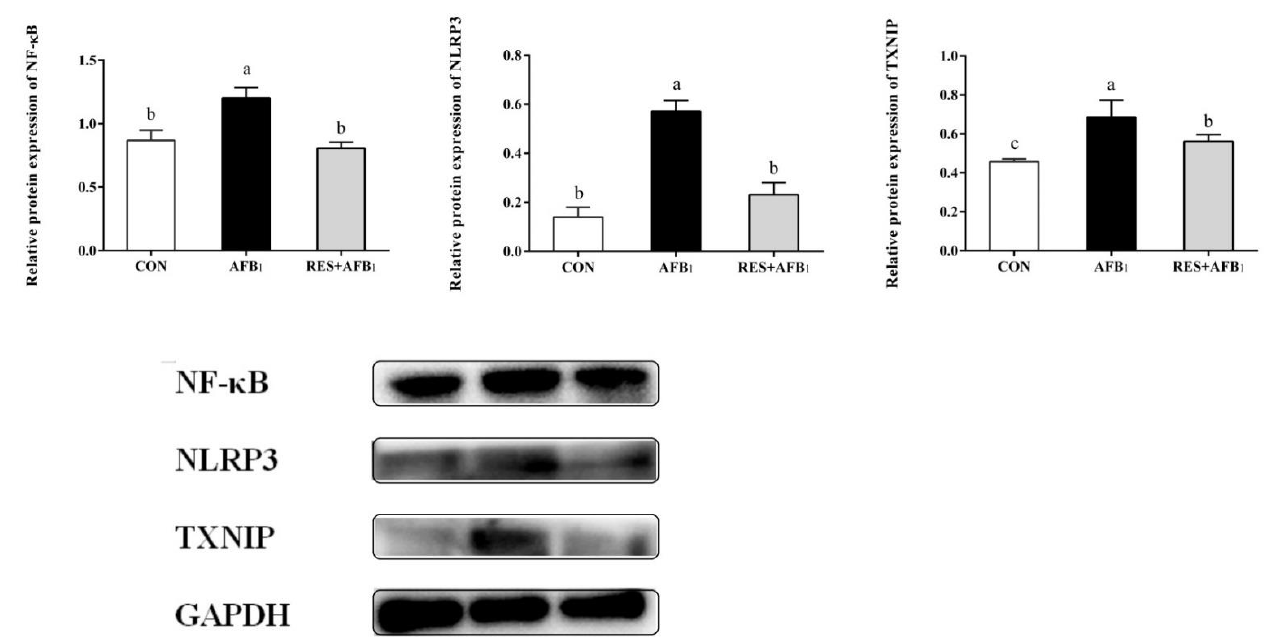
Figure 5. ( A – H ) Effect of RES on the mRNA expression levels of antioxidant genes in the ileum of AFB 1 -exposed duck. Values are expressed as mean ± SD, n = 8. Labeled (a, b, c, a > b > c) means in a row without a common letter differ, p < 0.05. IKK: Inhibitor of nuclear factor kappa-B kinase; p53: p53 tumor suppressor protein; TNF- α: Tumor necrosis factor - α; IL -6: Interleukin-6; IL-18: Interleu- kin-18.